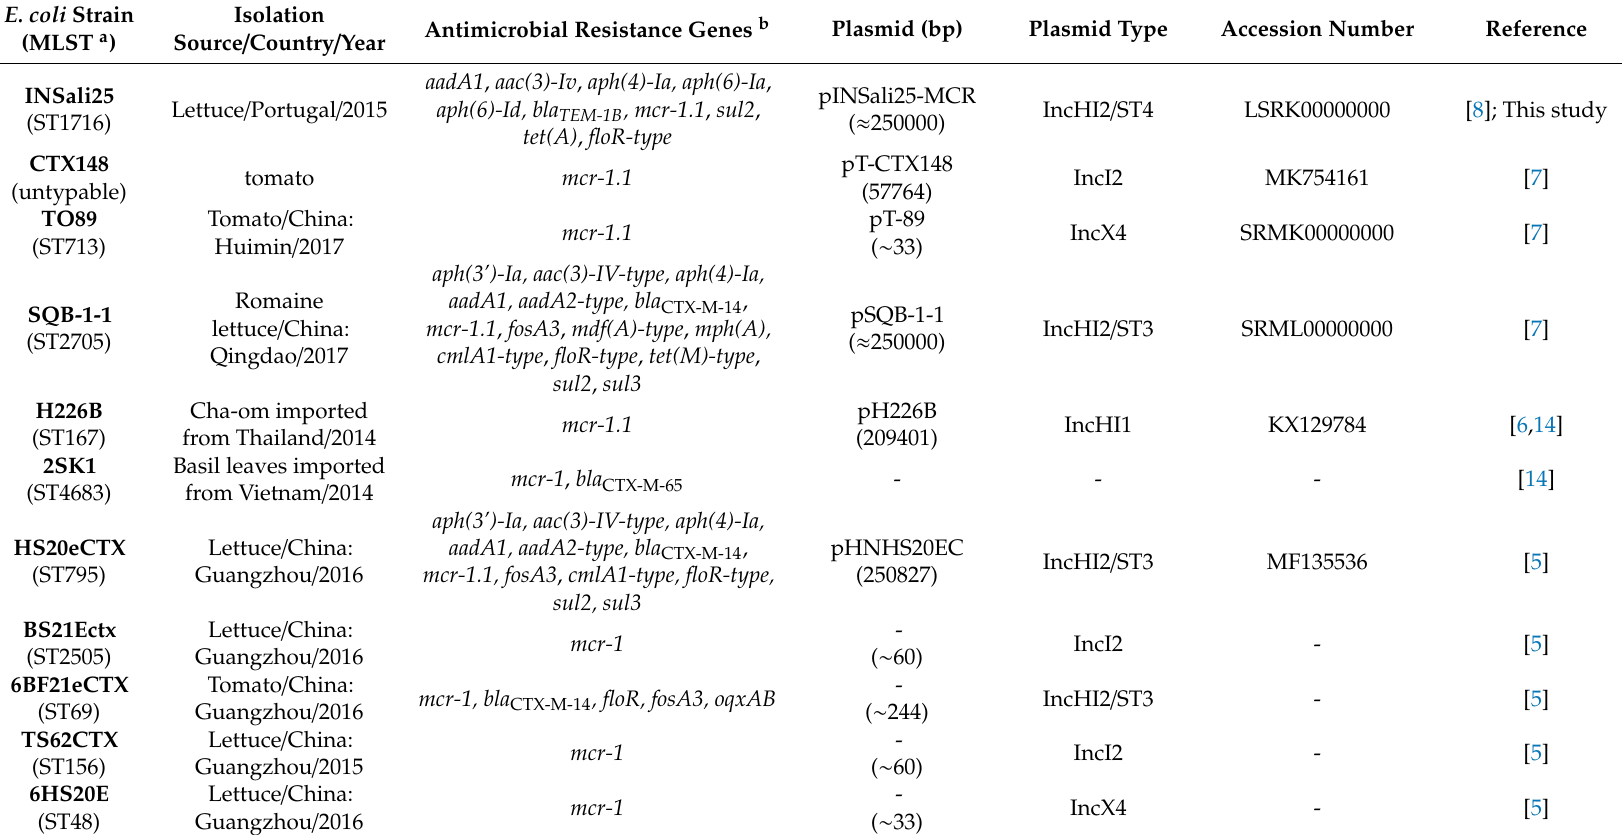
Table 2. Comparison of MCR-1-producing E. coli strains isolated from fresh